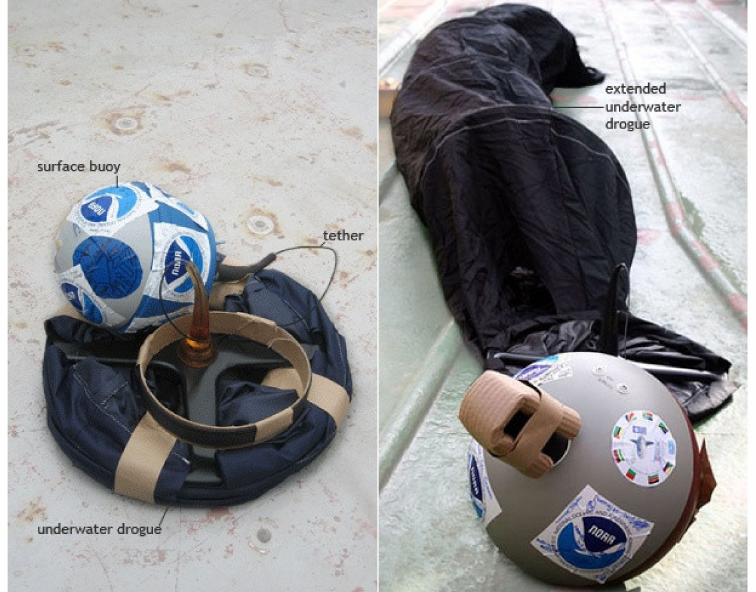
Figure 1. A drifter neatly compressed for deployment ( left ) and with the nylon drogue fully extended ( right ), as it will be in the water once the cardboard wraps dissolve. Photos cour- tesy of National Oceanic and Atmospheric Administration (NOAA)—Atlantic Oceanographic and Meteorological